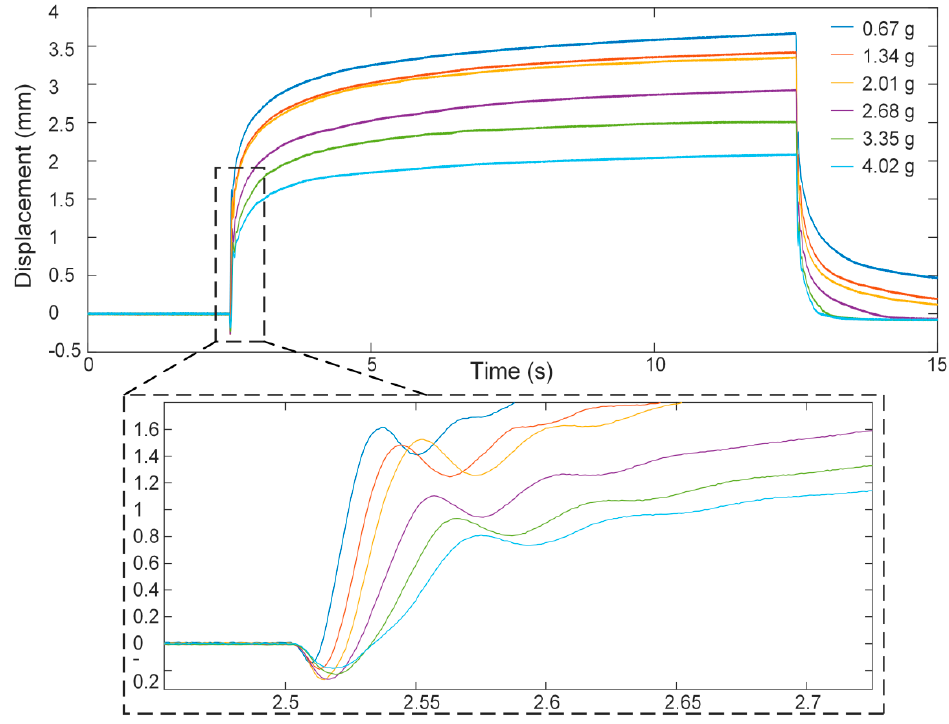
Figure 9. Vertical displacements of different loads when a 6 kV step input was applied to the e-textile DEA driven skin thermal regulation device.